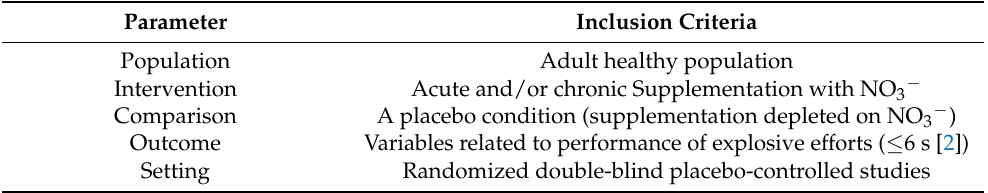
Table 1. Inclusion criteria according to the Population, Intervention, Comparison, Outcomes, and Study (PICOS)